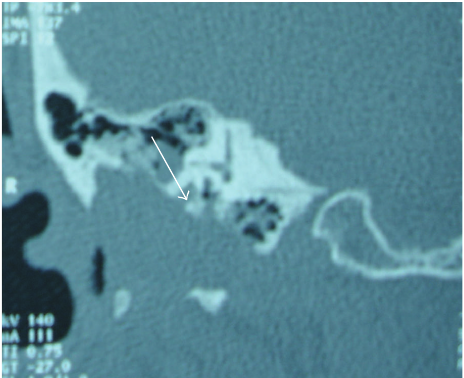
Figure 1: Coronal CT-scan.